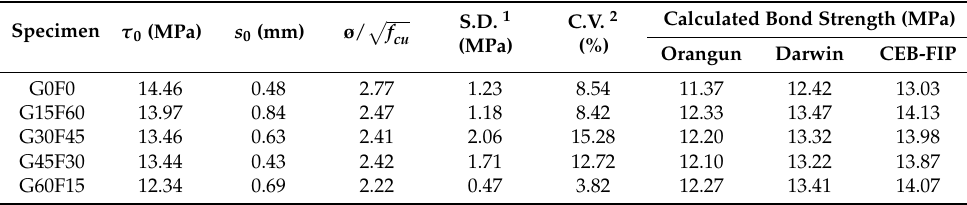
Table 5. Bond strength of V-type specimens at 28 days.